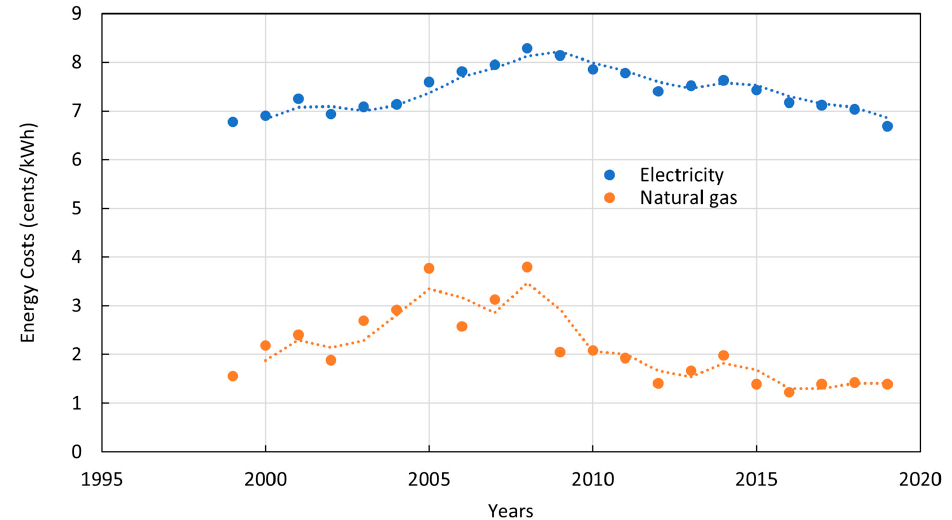
Figure A1. Costs comparison of the average United States industrial electricity and natural gas (USD kWh − 1 ) 1999–2019. Information was obtained from the United States EIA and average costs were normalized to January 2019 US currency [40,42].